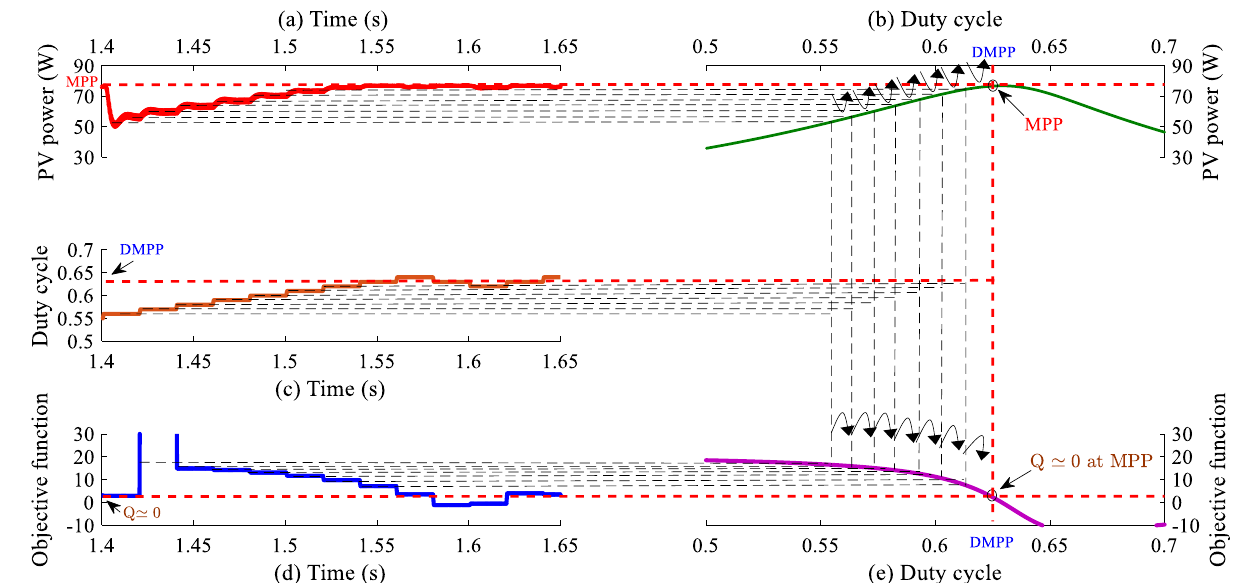
Figure 16. The tracking performance of CSL-MPPT of the PV-buck-boost converter system under variation of the load from 5 Ω to 10 Ω with fixed irradiance at 900 W/m 2 : ( a ) power versus time, ( b ) PV power versus duty cycle, and ( c ) duty cycle versus time, ( d ) objective function versus time, and ( e ) objective function versus duty cycle.